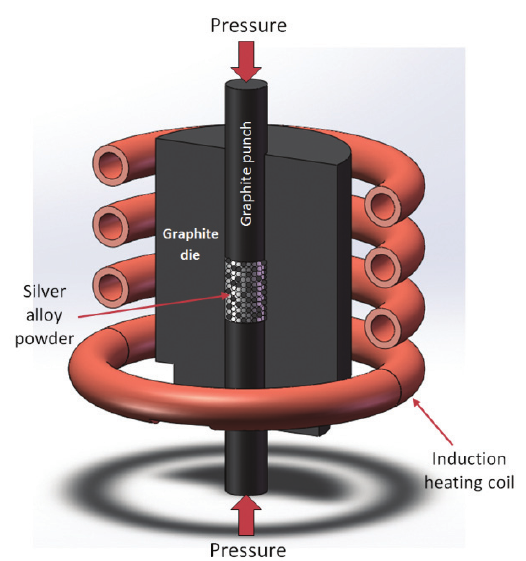
Figure 3. The hot pressing process: schematic of the